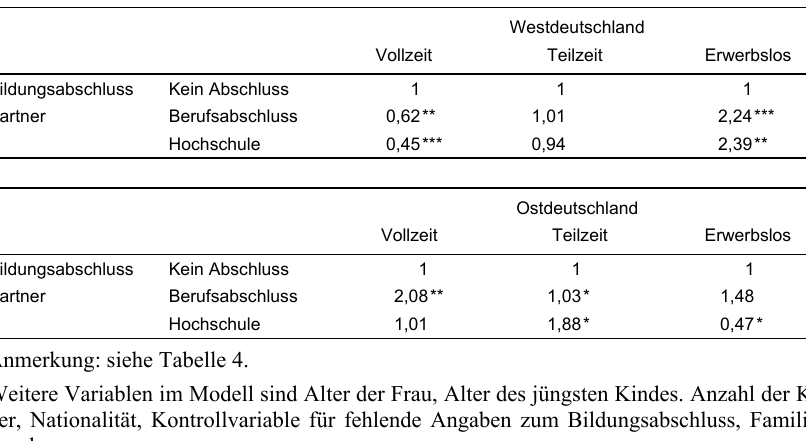
Tabelle 5: Multinomiale logistische Regression, Odds Ratios, der Einfluss des Bildungsabschlusses des